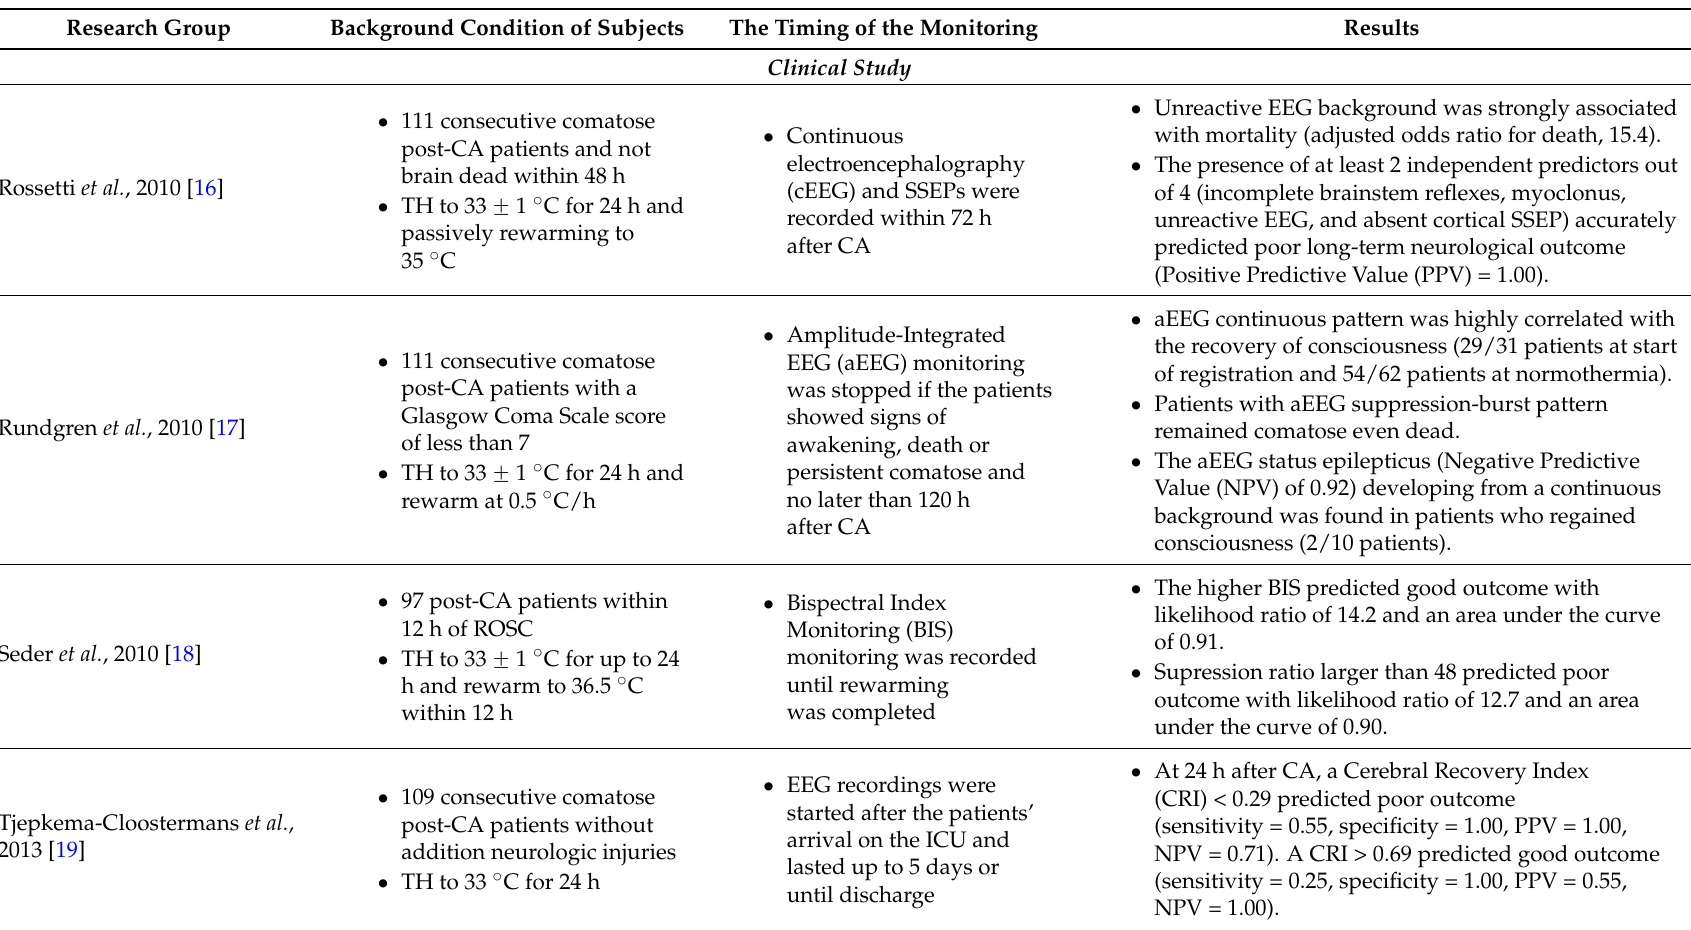
Table 1. Summary of electrophysiological research in post-cardiac arrest (CA) survivors with therapeutic hypothermia (TH)